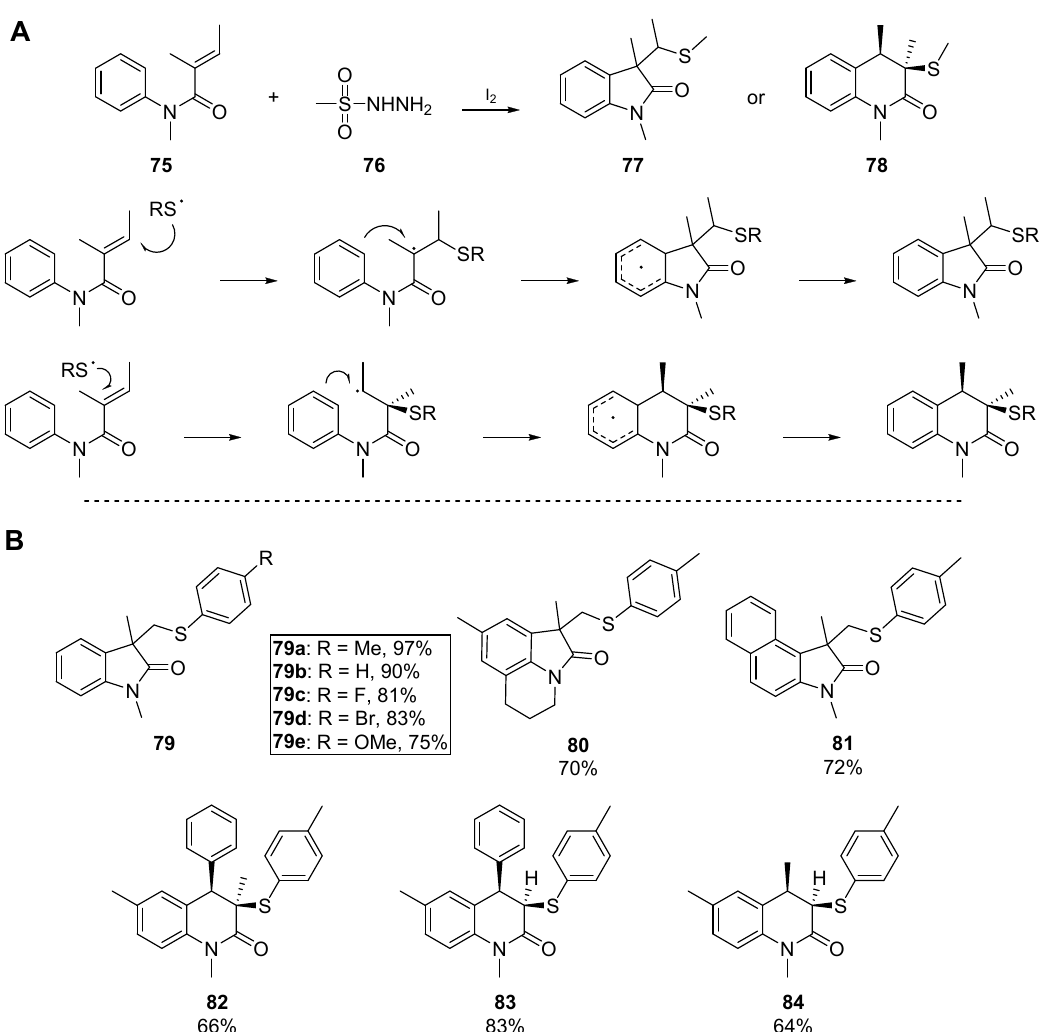
Scheme 13. The cyclization mechanism ( A ) and select examples ( B ) by Wang and